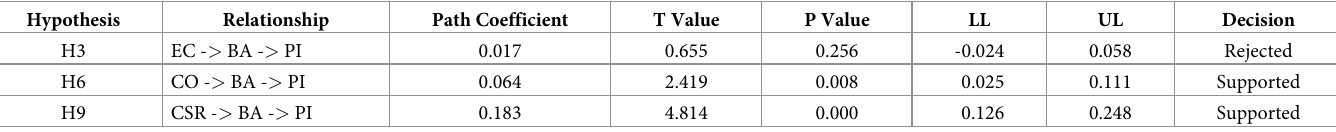
Table 7. Mediation